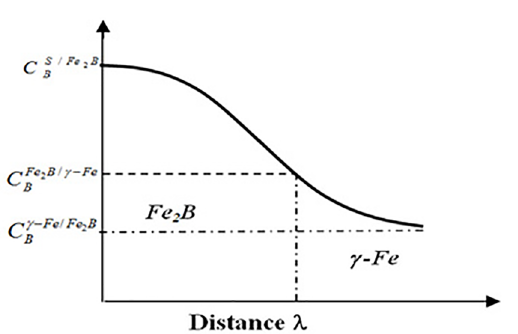
Figure 2. Diagram of boron concentration profile (Fe2B layer). Fig.2. Diagram of boron concentration profile (Fe2B layer).